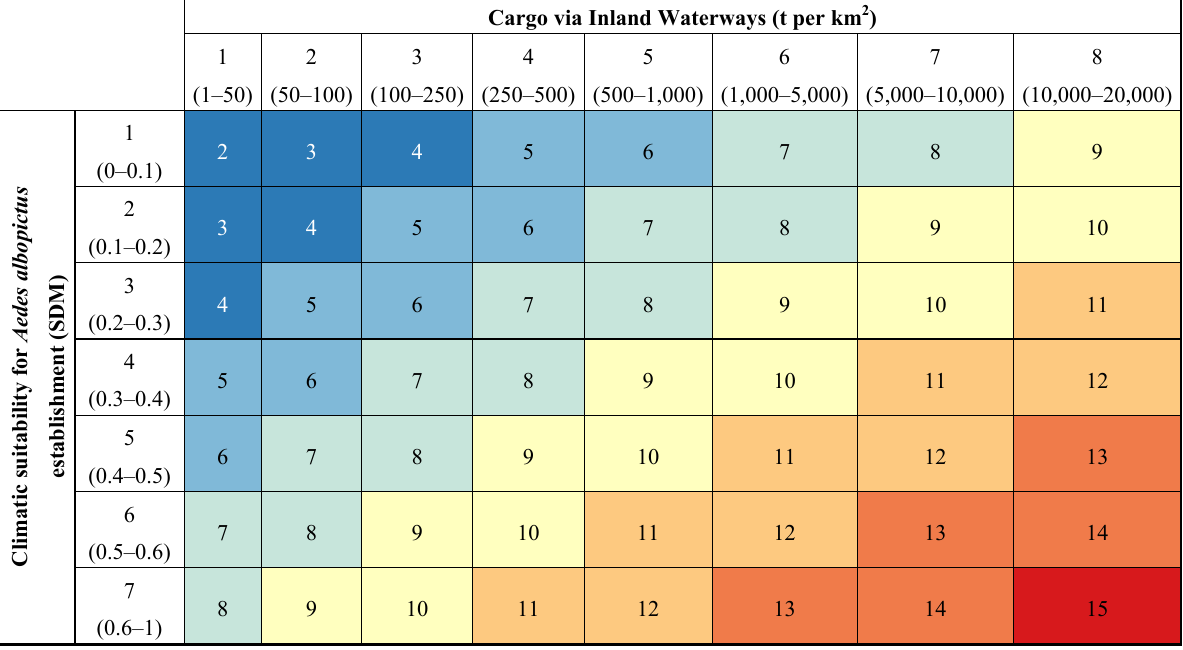
1. Combined risk evaluation taking into account climatic suitability for Aedes albopictus establishment and received cargo per area via inland waterway transport.